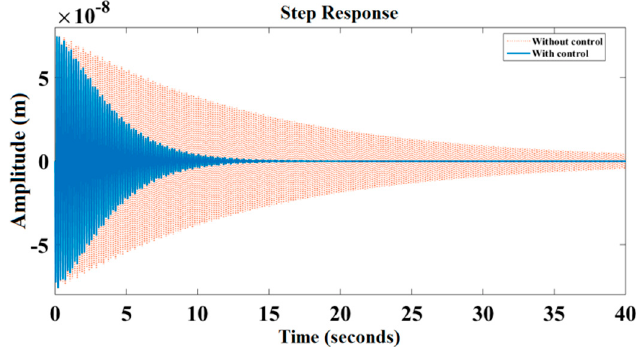
Figure 9. Step response of the beam (Sensors in FE2, Q = 10 11 , R = 1, Gc = 100).